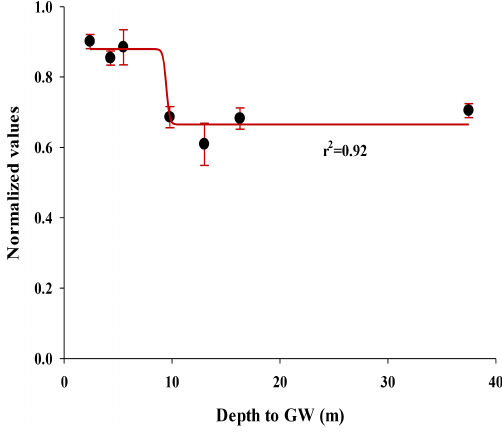
Figure 8. Ecosystem response to increase in depth-to- groundwater, fitted with four-parameter sigmoidal function. From Zolfaghar (2014).